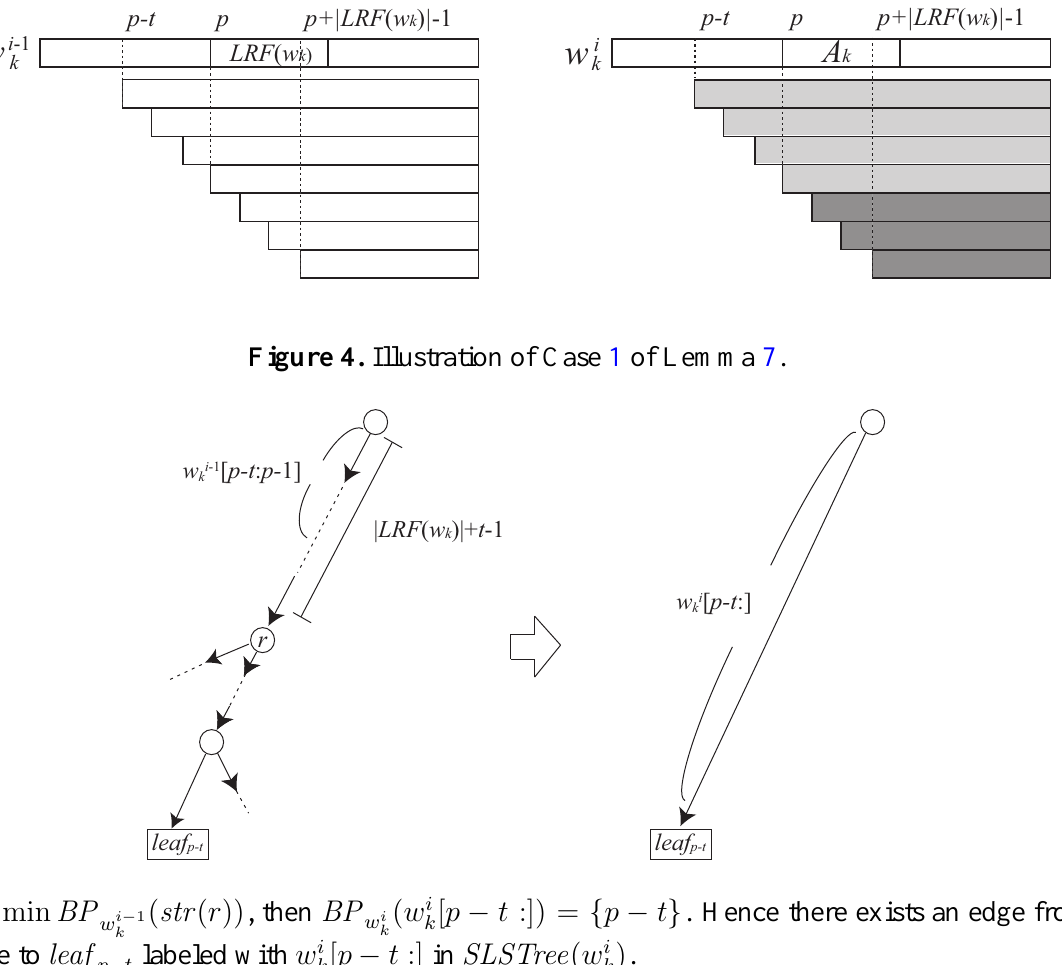
is replaced by non-terminal symbol A k